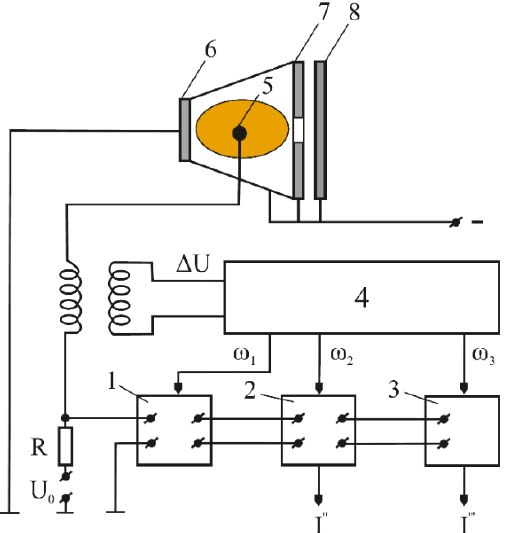
Figure 3. Measurement design: 1–3—synchronous detectors; 4—driving generator; 5—flat one-sided probe; 6—cathode; 7—main anode; and 8—control electrode [21].